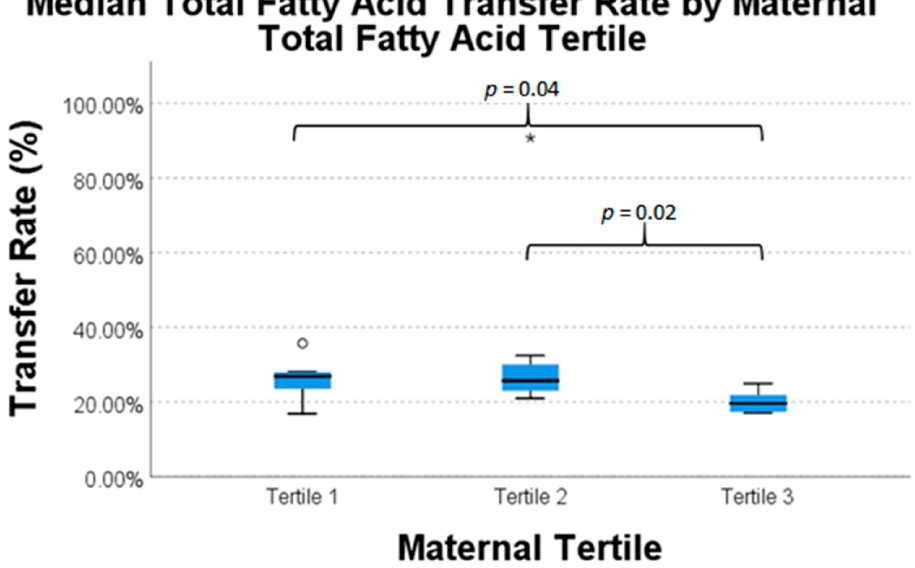
Figure 3. Intrauterine transfer percentage of total fatty acid across tertiles of maternal plasma concentration. Asterisk refers to Tertile 2.